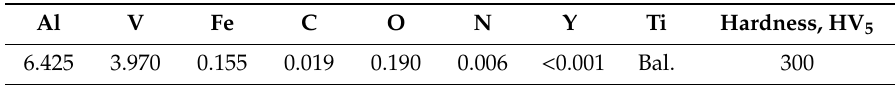
Table 2. Chemical composition (in weight %) and hardness of the work-piece material Ti6Al4V according to the material specification provided by material supplier Timet.